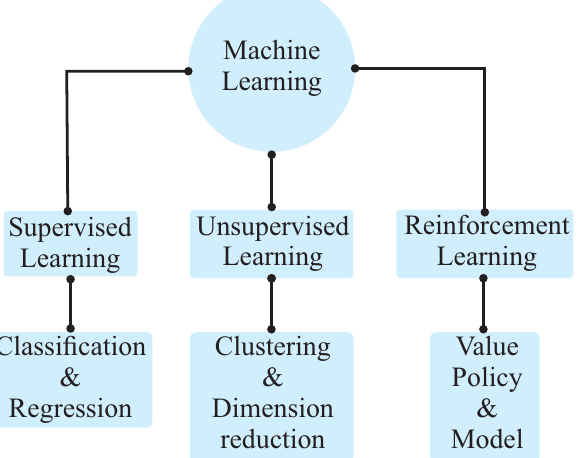
Figure 3. Categories of machine learning and commonly used classification & clustering